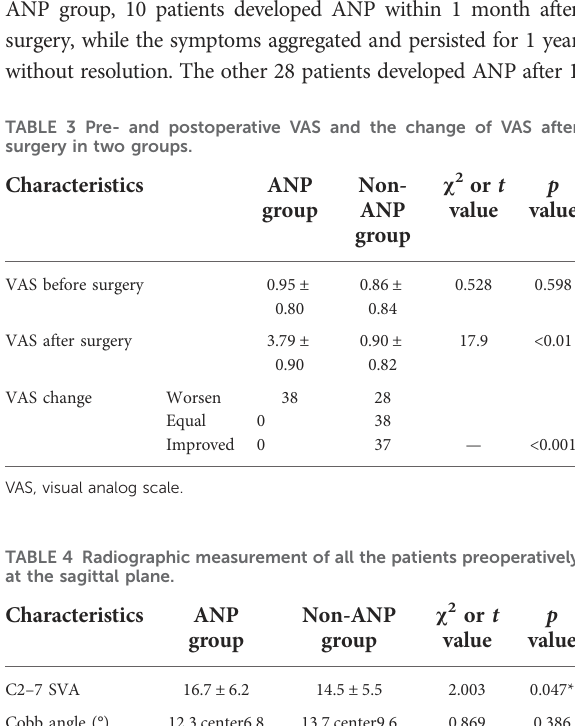
TABLE 2 Surgical information of the enrolled groups treated with single-door laminoplasty. Characteristics